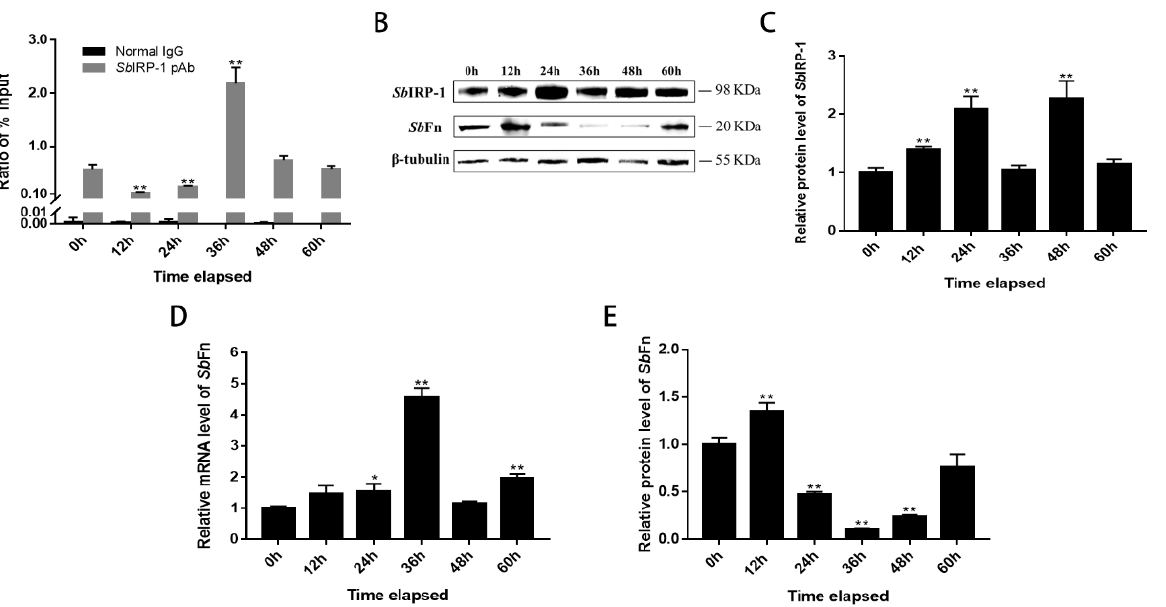
Figure 7. Sb IRP-1 pulled the translation of Sb Fn down post-OsHV-1 infection. ( A ) Immunoprecipitation of mRNA binding to r Sb IRP from hemocytes post-OsHV-1 infection. Sb IRP-1 polyclonal antibody and normal rabbit IgG (abclonal) were used to immuno-precipitate RNA binding to r Sb IRP-1 and unspecific binding RNA, respectively. The level of Sb Fn mRNA binding to r Sb IRP-1 was detected by qRT-PCR. (B ) The protein level of ( C ) Sb IRP-1 and ( E ) Sb Fn in hemocytes post-OsHV-1 infection was analyzed using Western blot and the relative protein expression level was analyzed by calculating the density of target protein/ β -tubulin. ( D ) Expression profiles of Sb Fn mRNA post OsHV-1 infection in the hemocytes. Asterisks indicate significant differences: ** p < 0.01, * p <